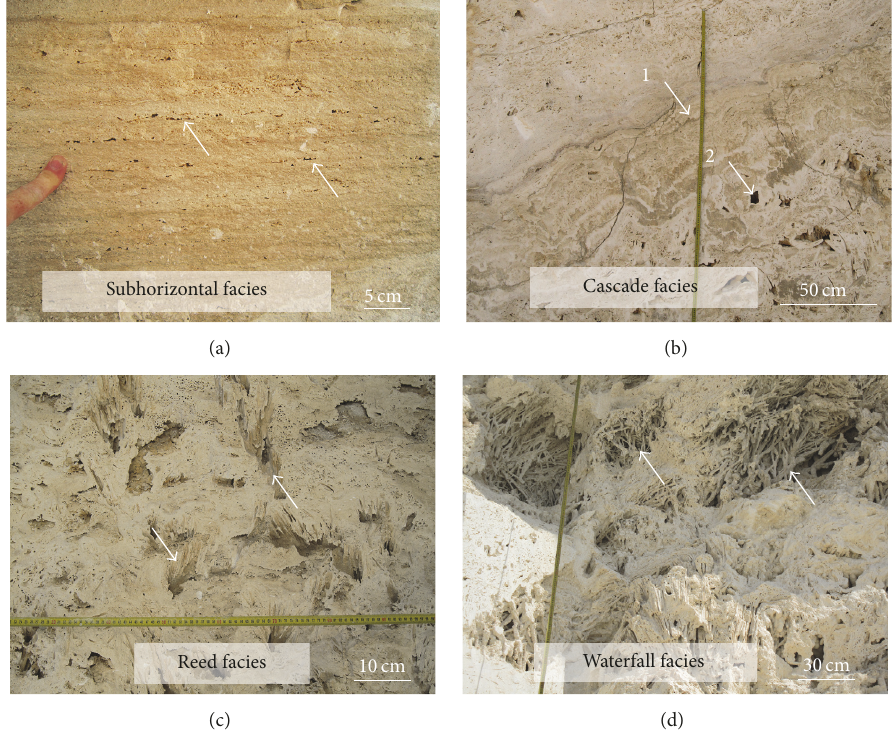
Figure 1: Dominant lithofacies types in the studied continental carbonate quarries. (a) Subhorizontal facies with pseudofenestral porosity (arrows). (b) Cascade facies with dendrite crusts (arrow 1) and shelter pores (arrow 2). (c) Reed facies with reed moldic porosity (arrows). (d) Waterfall facies with plant framework porosity